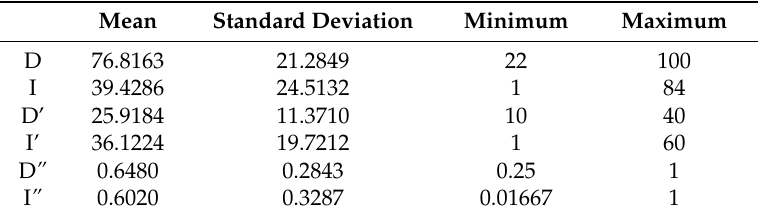
Table 2. Descriptive analysis of engineer leadership